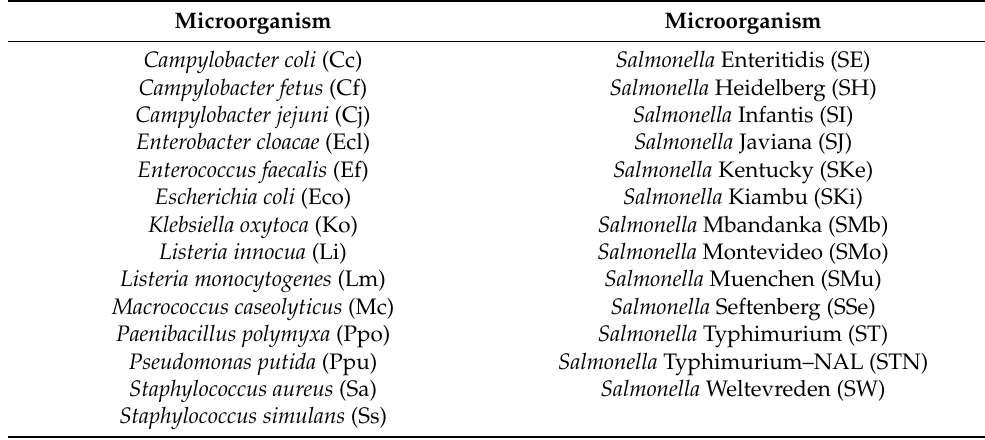
Table 1. List of microorganisms used in this experiment and their